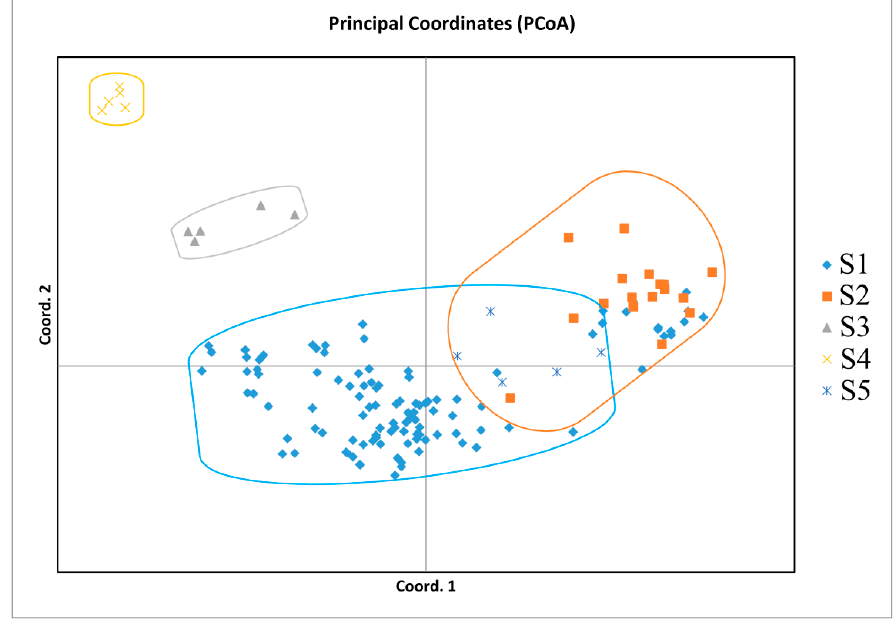
Figure 4. PCoA of oil-tea camellia samples based on SSR